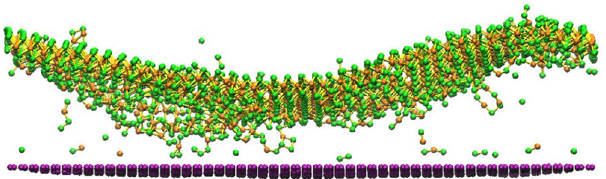
Figure 13. Morphologies of the MoS 2 /graphene heterostructures irradiated with 80 eV, 5.27 × 10 14 /cm 2